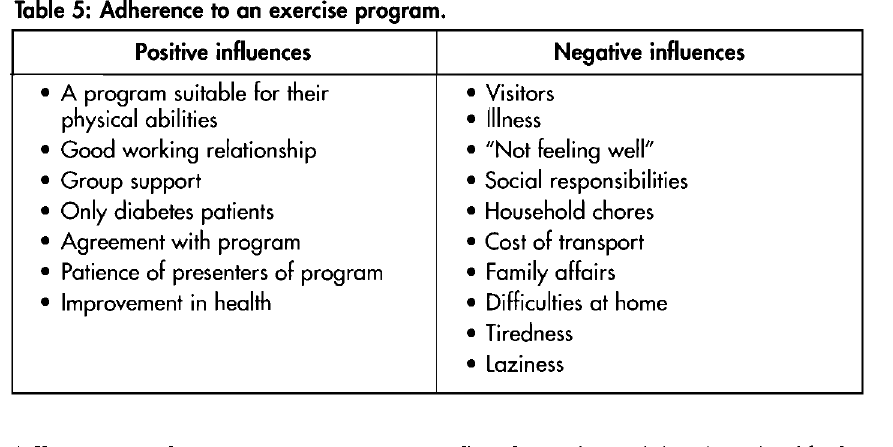
Table 5: Adherence to an exercise